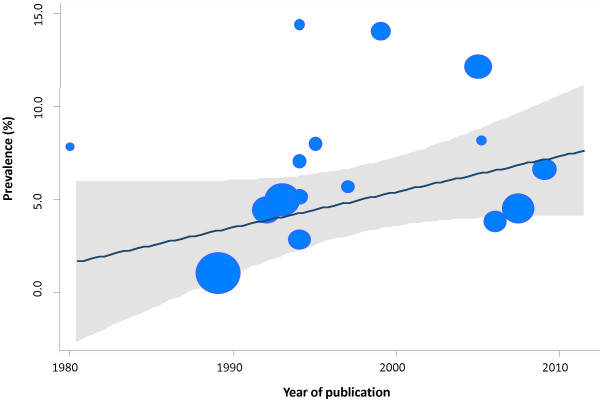
Relationship between year of publication and the prevalences of ADHD among children and adolescents in Spain. Meta-regression analysis. Note: The size of the bubble is inversely related to the variance of the study. The solid line represents the linear regression (year of publication as the meta-independent variable). The shaded area corresponds to the confidence intervals of the prediction.